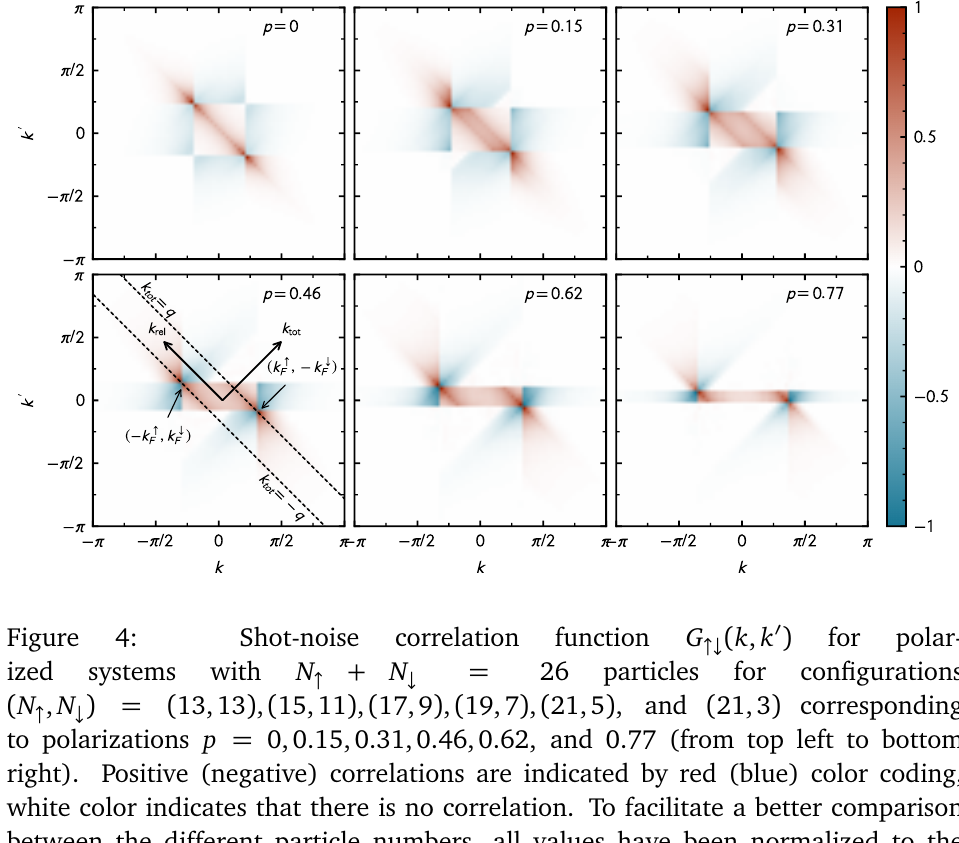
Figure 4: Shot-noise correlation function G ↑↓ ( k , k (cid:48) ) for polar- ized systems with N ↑ + N ↓ = 26 particles for configurations ( N ) = ( 13,13 ) , ( 15,11 ) , ( 17,9 ) , ( 19,7 ) , ( 21,5 ) , and ( 21,3 ) corresponding ↑ , N ↓ to polarizations p = 0,0.15,0.31,0.46,0.62, and 0.77 (from top left to bottom right). Positive (negative) correlations are indicated by red (blue) color coding, white color indicates that there is no correlation. To facilitate a better comparison between the different particle numbers, all values have been normalized to the respective maximal absolute values of the shot-noise such that the range of the correlation is always in the interval [ − 1,1 ] . Lower left panel : The direction along the momentum-space diagonal defines the total momentum k of a pair whereas tot the direction along the anti-diagonal defines the relative momentum k . The two rel = ± q which include the points of opposite dashed lines show lines of constant k tot Fermi momenta labeled with their respective momentum-space